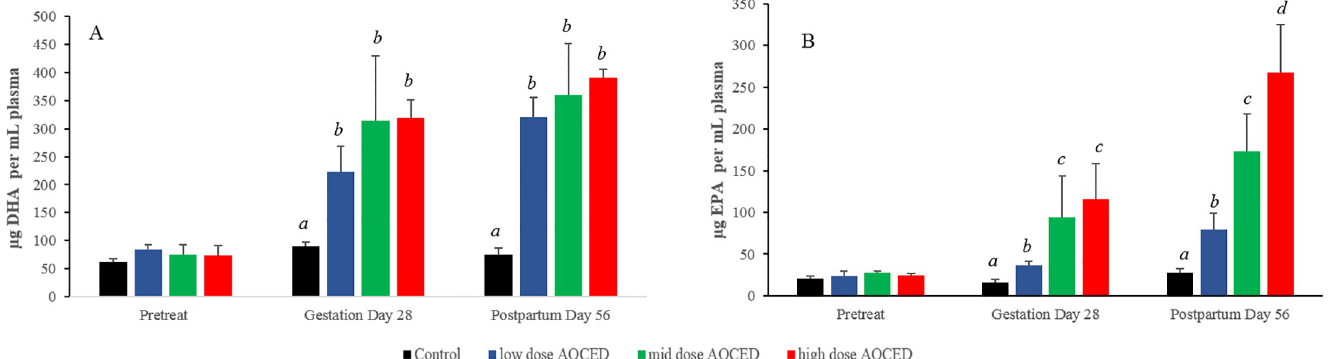
Fig 5. Plasma DHA (A) and EPA (B) levels in dams. Values are given as Mean + SD and expressed as μ g/mL, n = 4 in each group. a , b , c , d signify between-group differences at a timepoint (p <